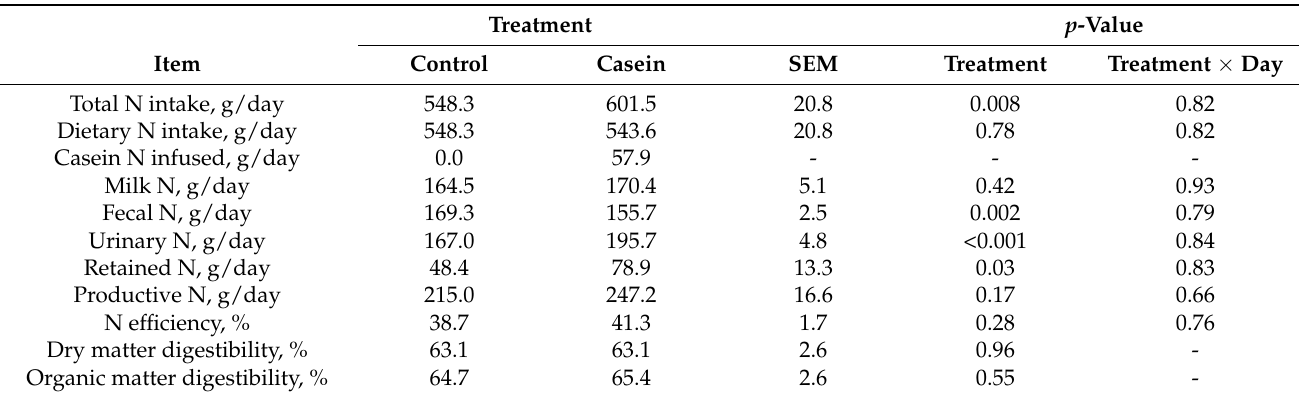
Table 2. Effect of casein supplementation on nitrogen (N) intake, excretion, balance, efficiency, and diet digestibilities from days 5 through 8 of each period.